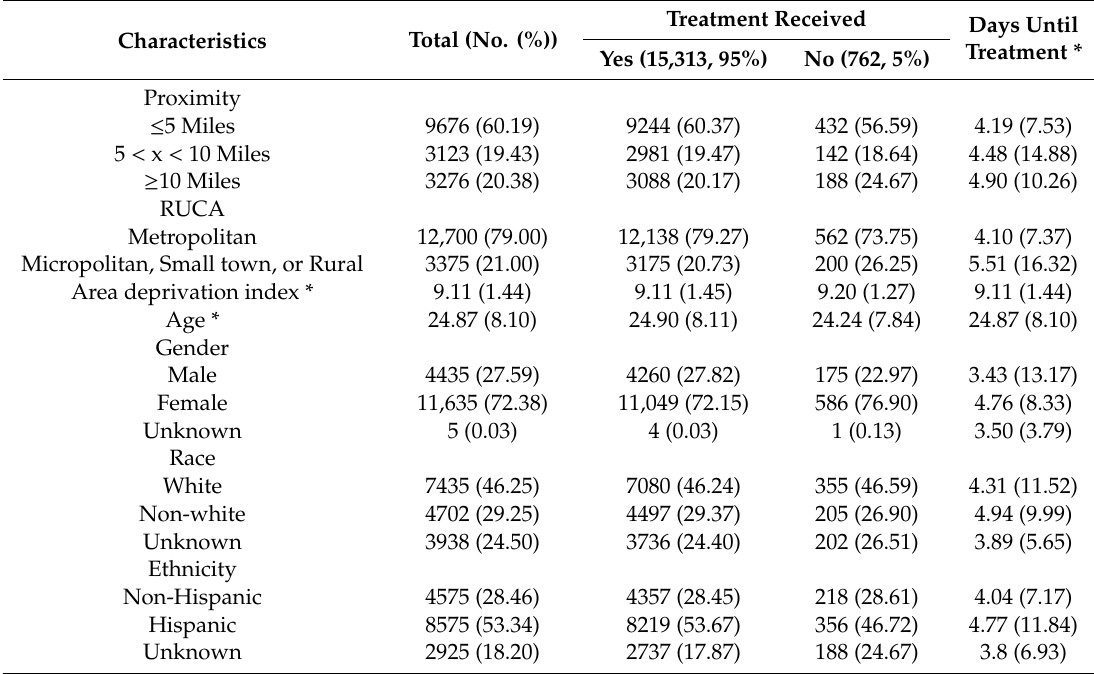
Characteristics